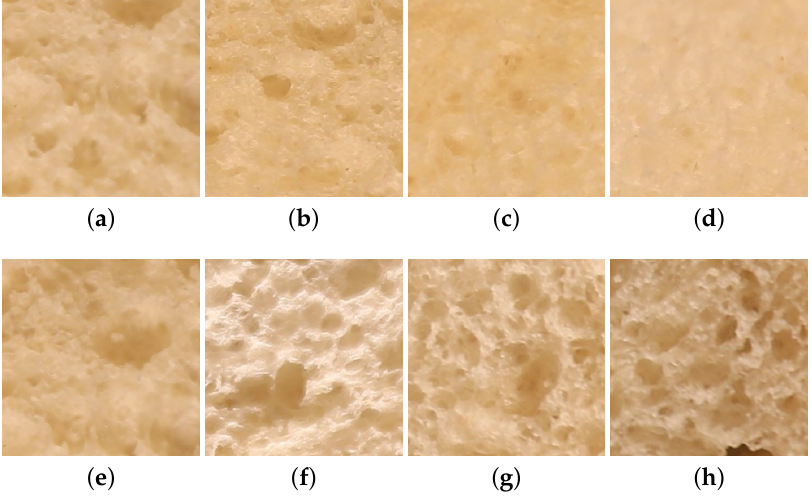
Figure 4. Changes in the visual appearance of a white bread sample under various lighting geometries and viewing directions. Images ( a – d ) were acquired under the same lighting direction (90°). Images ( e – h ) were acquired under the same viewing direction (90°). For images ( a – d ) the lighting direction was fixed at 90° and the viewing directions are 90°, 60°, 35°, and 10°, respectively. For the images ( e – h ), the viewing direction is fixed at 90° and the lighting directions are 90°, 65°, 45°, and 20°, respectively.